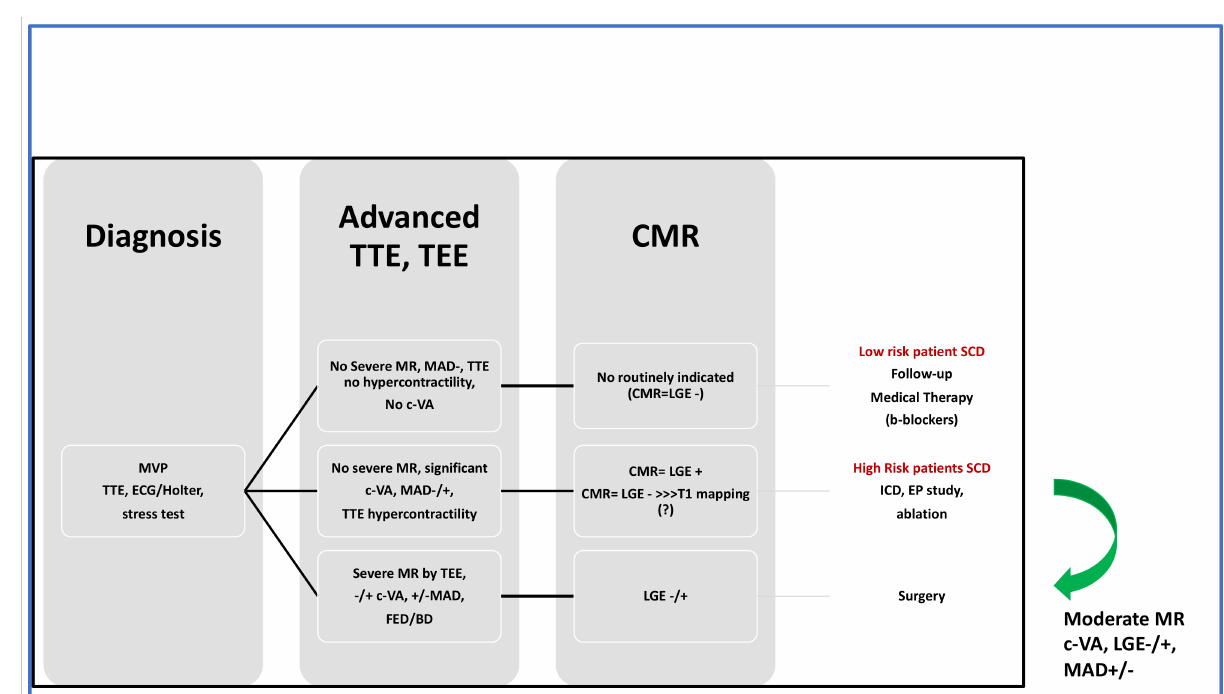
Figure 8. Multimodality approach for therapeutic decision making. TTE, transthoracic echocardiog- raphy; TEE, transesophageal echocardiography; CMR, cardiac magnetic resonance; ICD, implantable cardioverter-defibrillator (ICD); EP, electrophysiology study; FED, fibroelastic deficiency; BD, Barlow disease; LGE, late gadolinium enhancement; c-VA, complex ventricular arrhythmias; MAD, mitral annulus